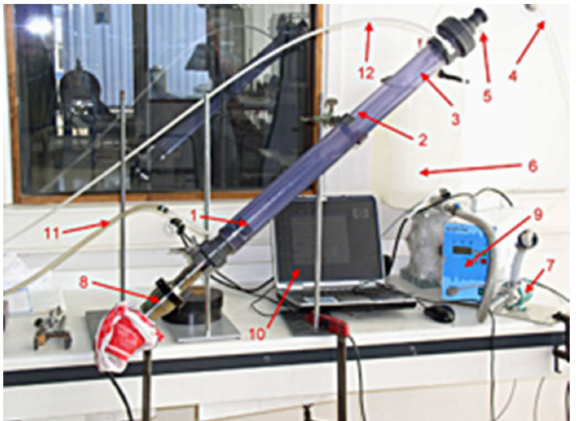
Figure 3. Micro-pilot for pickling and passivation of the hypotubes. 1: Tube originating from